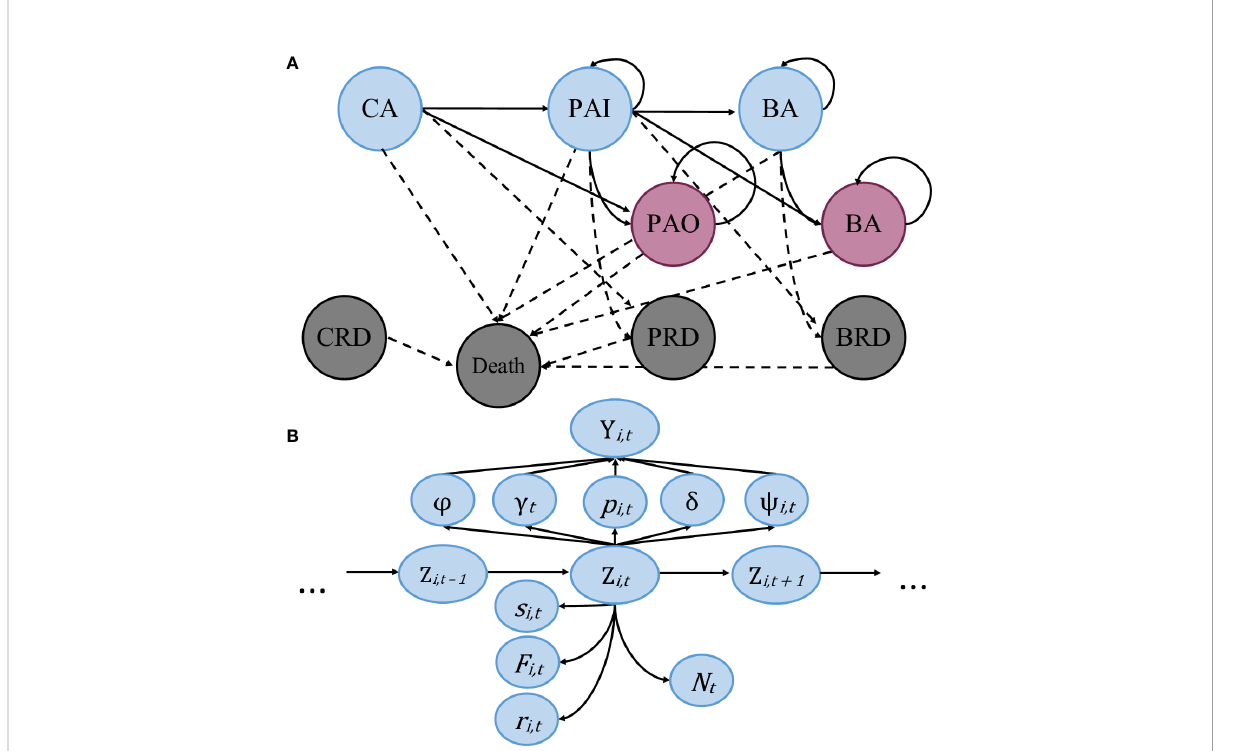
FIGURE 1 Multinomial tree diagrams showing the transitions between states and the model structure. (A) Simpli fi ed stage structure of the model, with circles representing states of an individual, blue circles represent individuals alive within the study area, red represents individuals alive outside the study area, and grey represents dead individuals. Solid lines represent the movement of individuals between states from time t to t+1 , and dotted lines representing possible transitions to mortality. (B) Graphical depiction of the statistical model. State Z is dependent upon removal entry probability ( g ), initial state assignment ( j ), transition probability from pre-breeder to breeder ( y ), unknown state assignment ( d ), and recapture probability ( p ), all of which are dependent upon the observation ( Y ). Lastly, we have true survival probability ( s ), fi delity probability ( F ), recovery probability ( r ), and abundance ( N ), which are estimated as a function of individual state, informed by the available